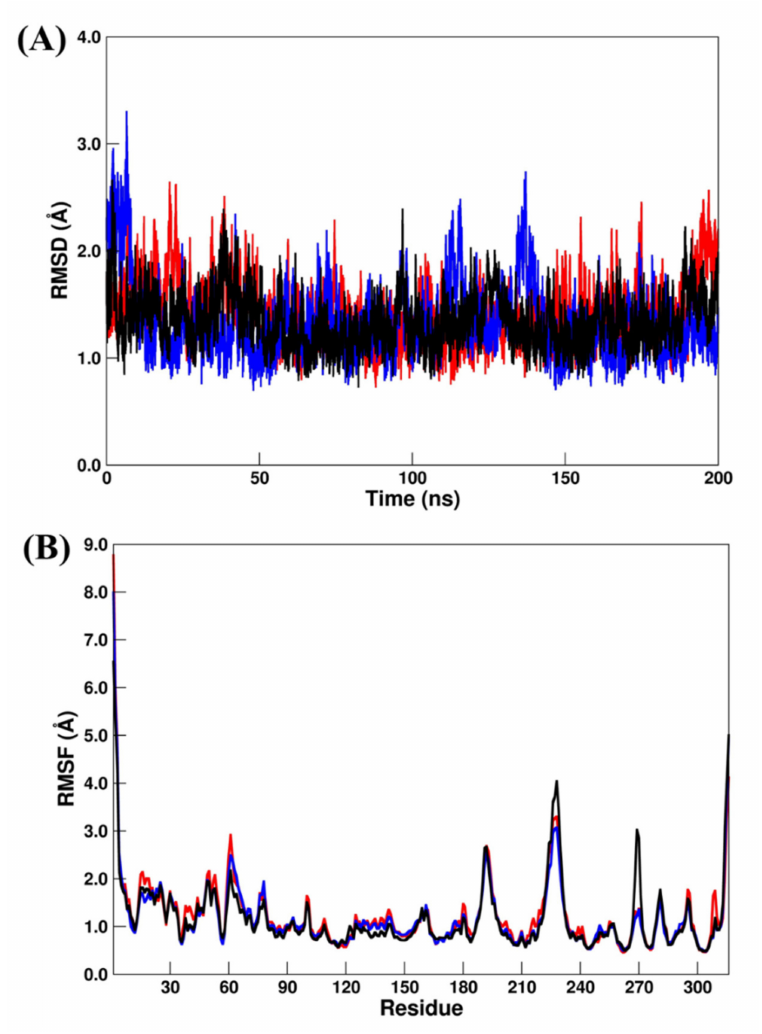
Figure 2. ( A ) RMSD and ( B ) RMSF plots for PLpro–GRM (red line), PLpro–OUB (blue line), and PLpro–SLM (black line). All values are reported in